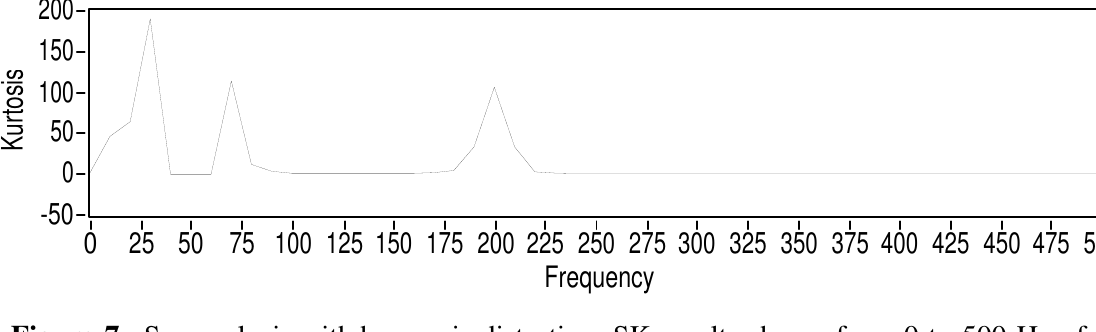
Figure 7. Sag analysis with harmonic distortion. SK results shown from 0 to 500 Hz of a sag with harmonic distortion, with Gaussian additive noise with σ = 0 . 05